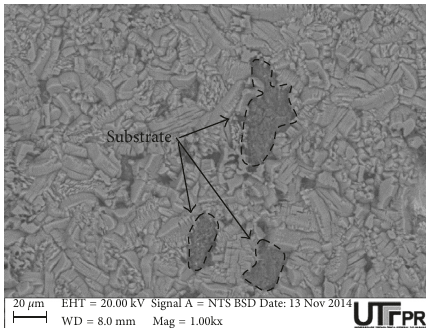
Figure 5: Top surface of the zinc phosphate layer on shot-blasted steel.